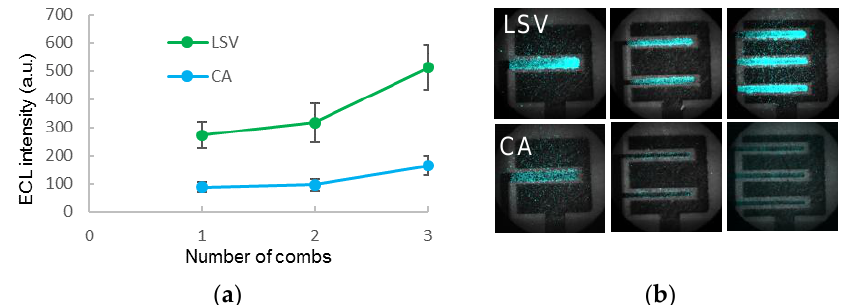
Figure 3. ( a ) ECL intensities of 50 µM luminol from LSV and CA; ( b ) Images of luminol ECL on different comb-shaped electrodes by LSV (top) and CA (bottom).